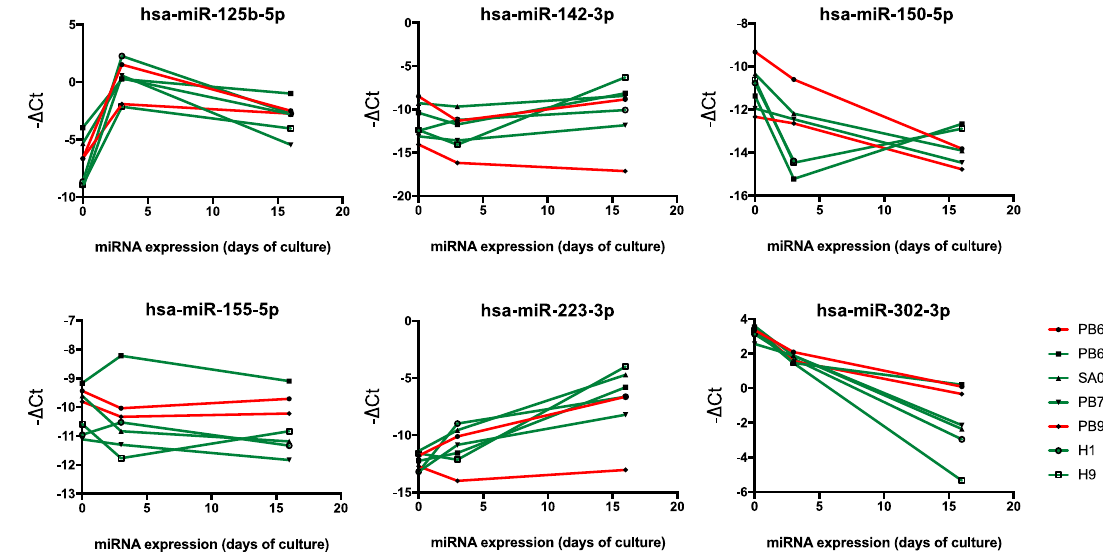
Figure 2. Hematopoiesis-related miRNA expression during EB culture. Five hematopoietic-competent PSCs (PB 6.1, PB7, SA01, H1, H9) and two hematopoietic–deficient ones (PB6, PB9) were analyzed at 0, 3 and 16 days in the course of hematopoietic differentiation (day 0 representing the undifferentiated stage) by qRT-PCR. Graphs represent the expression kinetics of hsa-miR-125b-5p, hsa-miR-142-3p, hsa-miR-150-5p, hsa-miR-155-5p, hsa-miR-223-3p, and the hPSC-specific miR-302-3p, estimated by a – ∆ Ct calculation (with ∆ Ct = Ct miRNA – Ct RNU48). Hematopoietic-competent and hematopoietic-deficient PSCs are represented by green and red lines,